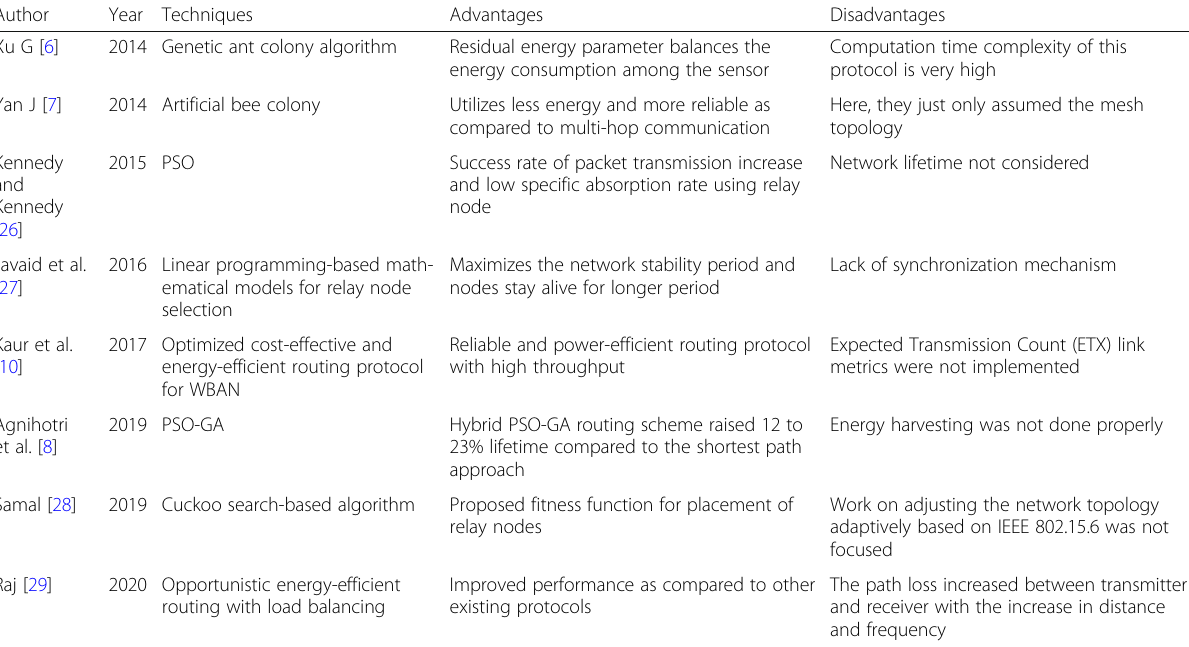
Table 1 Comparative analysis of some of the existing techniques